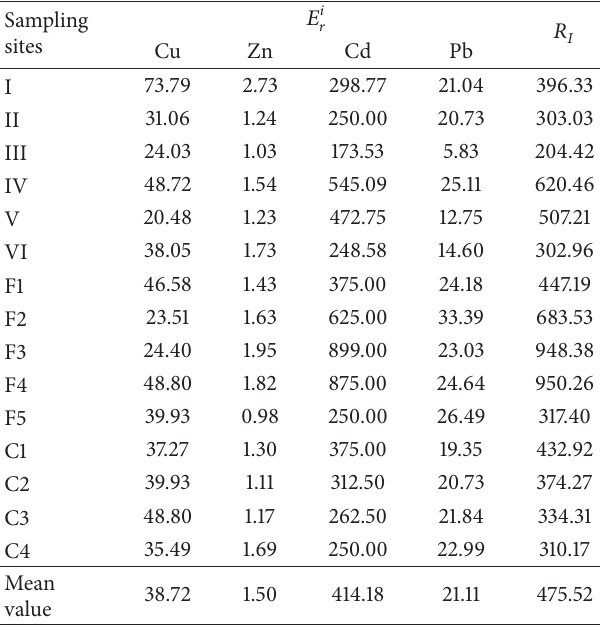
Table 2: Pollution grades of potential ecological risk of